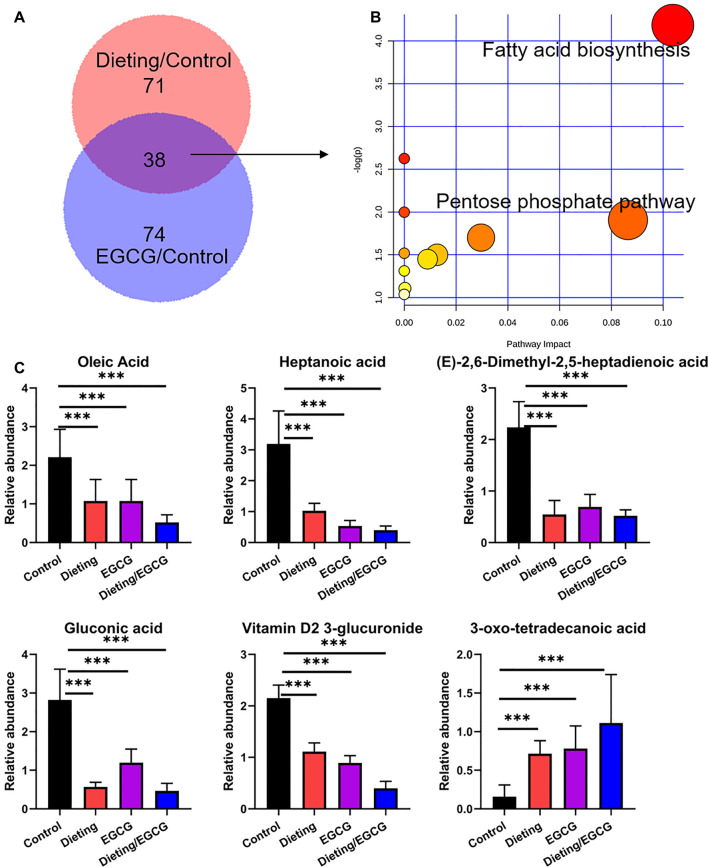
EGCG simulates the effect of dieting on fat loss. (A) The differential metabolites amount between dieting and control is displayed as pink, while that between EGCG and control is displayed as purple. The Venn diagram shows the shared metabolites between EGCG and dieting. (B) Pathway enrichment of 38 common metabolites. (C) Relative abundance of fat loss biomarkers. ***p < 0.001.